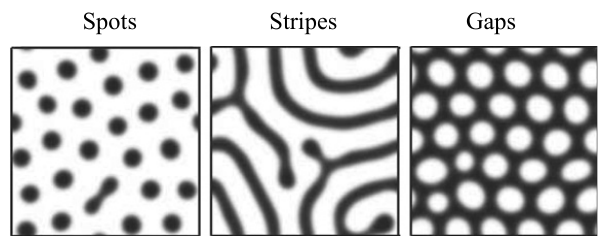
Figure 17. The model results show the vegetation pattern develop- ment from an originally bare state into a uniformly distributed veg- etation, reflecting the system’s ability for optimal self-organisation with respect to water resources (Gilad et al.,